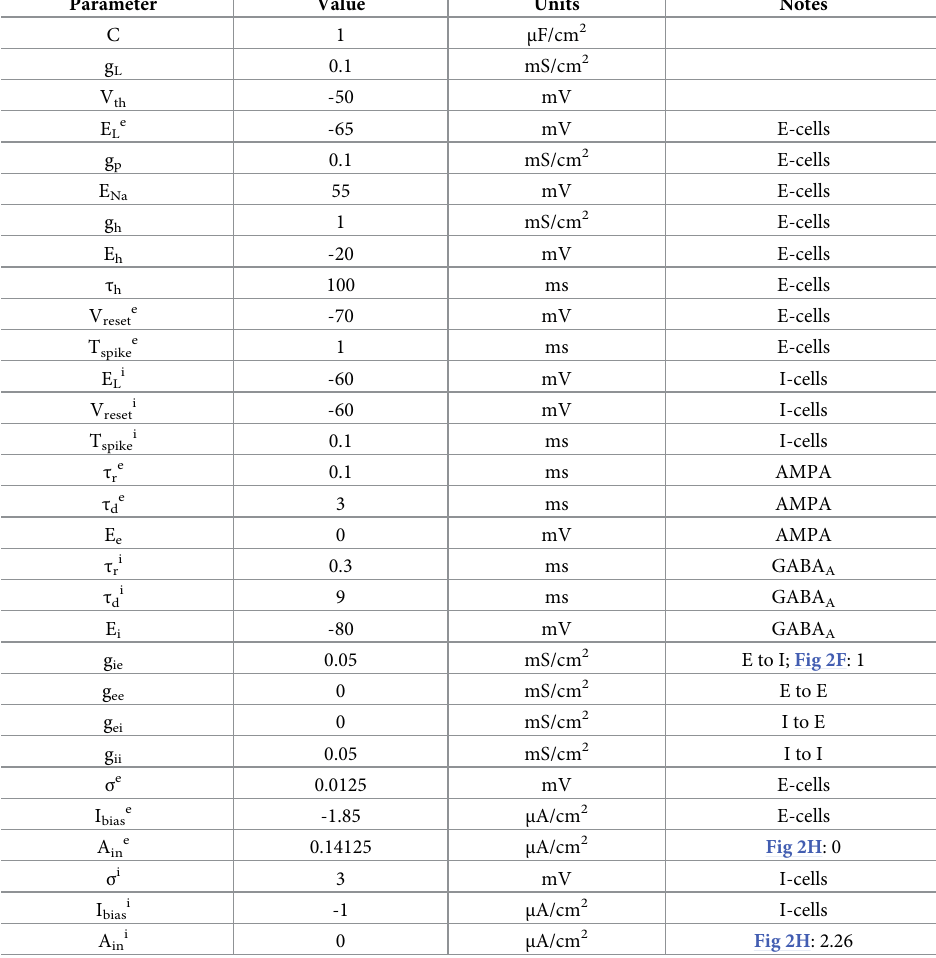
Table 1. Parameters used for modeling inheritance of resonance generated at the level of membrane potential fluctuations (Fig 2F–2H).